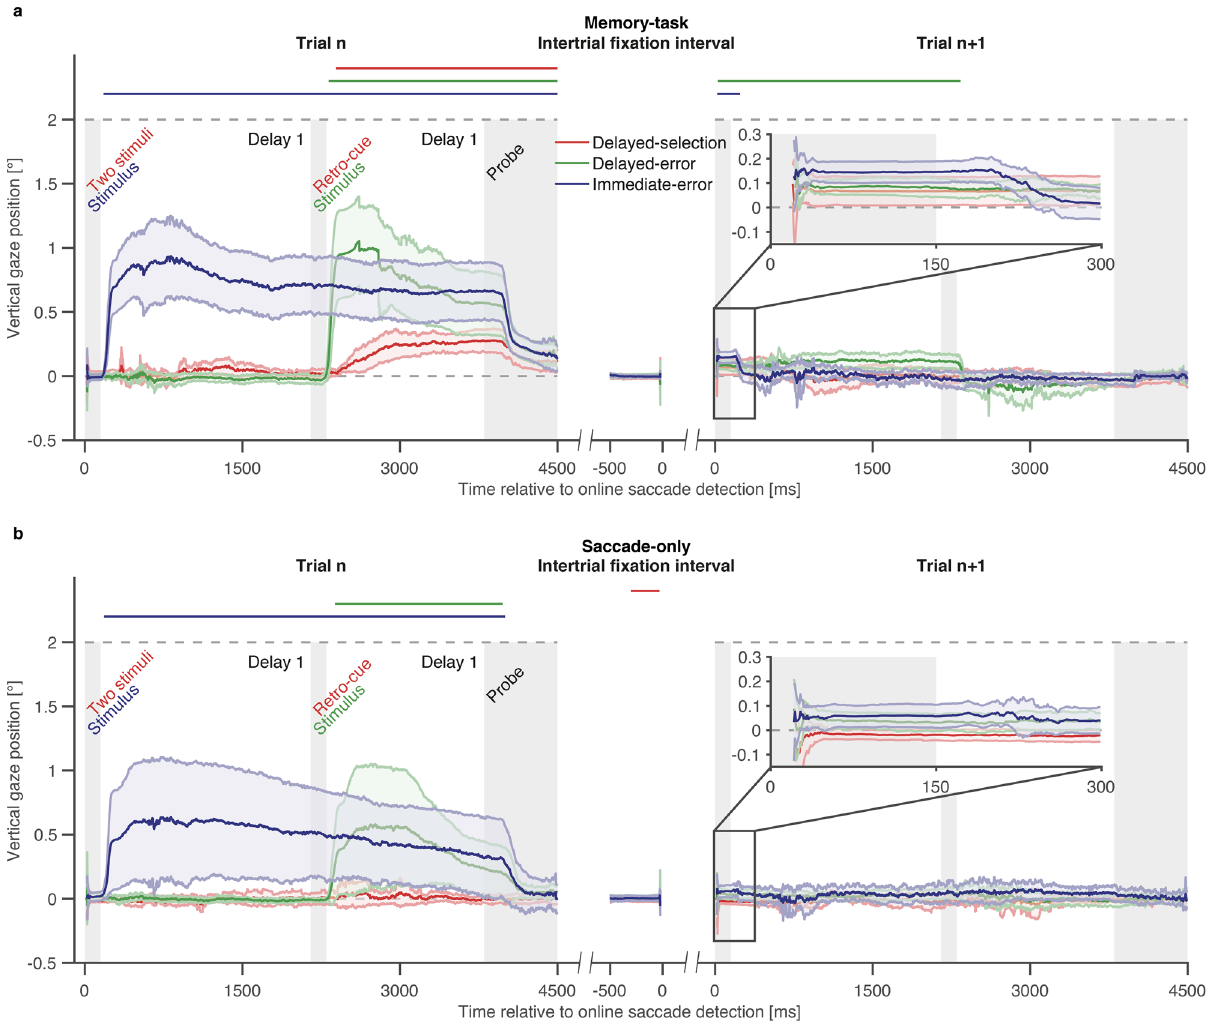
Figure 3. Gaze bias in trial n and n + 1. ( a ) The three colored lines represent the average vertical gaze position as a function of time in the memory-task experiment; positive gaze positions represent gaze positions closer to the location of the task-relevant stimulus in trial n. Colored shaded areas represent 95% confidence intervals. Colored horizontal bars above each plot mark significant clusters in the respective condition. The position of the task-relevant (+ 2°) stimulus in trial n is indicated by the dashed, grey line. In trial n + 1, the task-relevant stimulus appeared randomly at a vertical position of + 2° or − 2°. Grey shaded areas mark, from left to right, display duration of the stimulus (in the delayed-selection and immediate-error condition), the presentation duration of the auditory retro-cue (and display duration of the task-relevant stimulus in the delayed-error condition), and the first 700 ms of the response phase. The two areas between the grey shaded areas represent delay 1 and 2, respectively. The data are shown time-locked to online saccade detection. ( b ) Average vertical gaze position as a function of time in the saccade-only experiment. Conventions are the same as in panel ( a ). ( a , b ) Insets in trial n + 1 represent the zoomed in data from the first 300 ms after online saccade